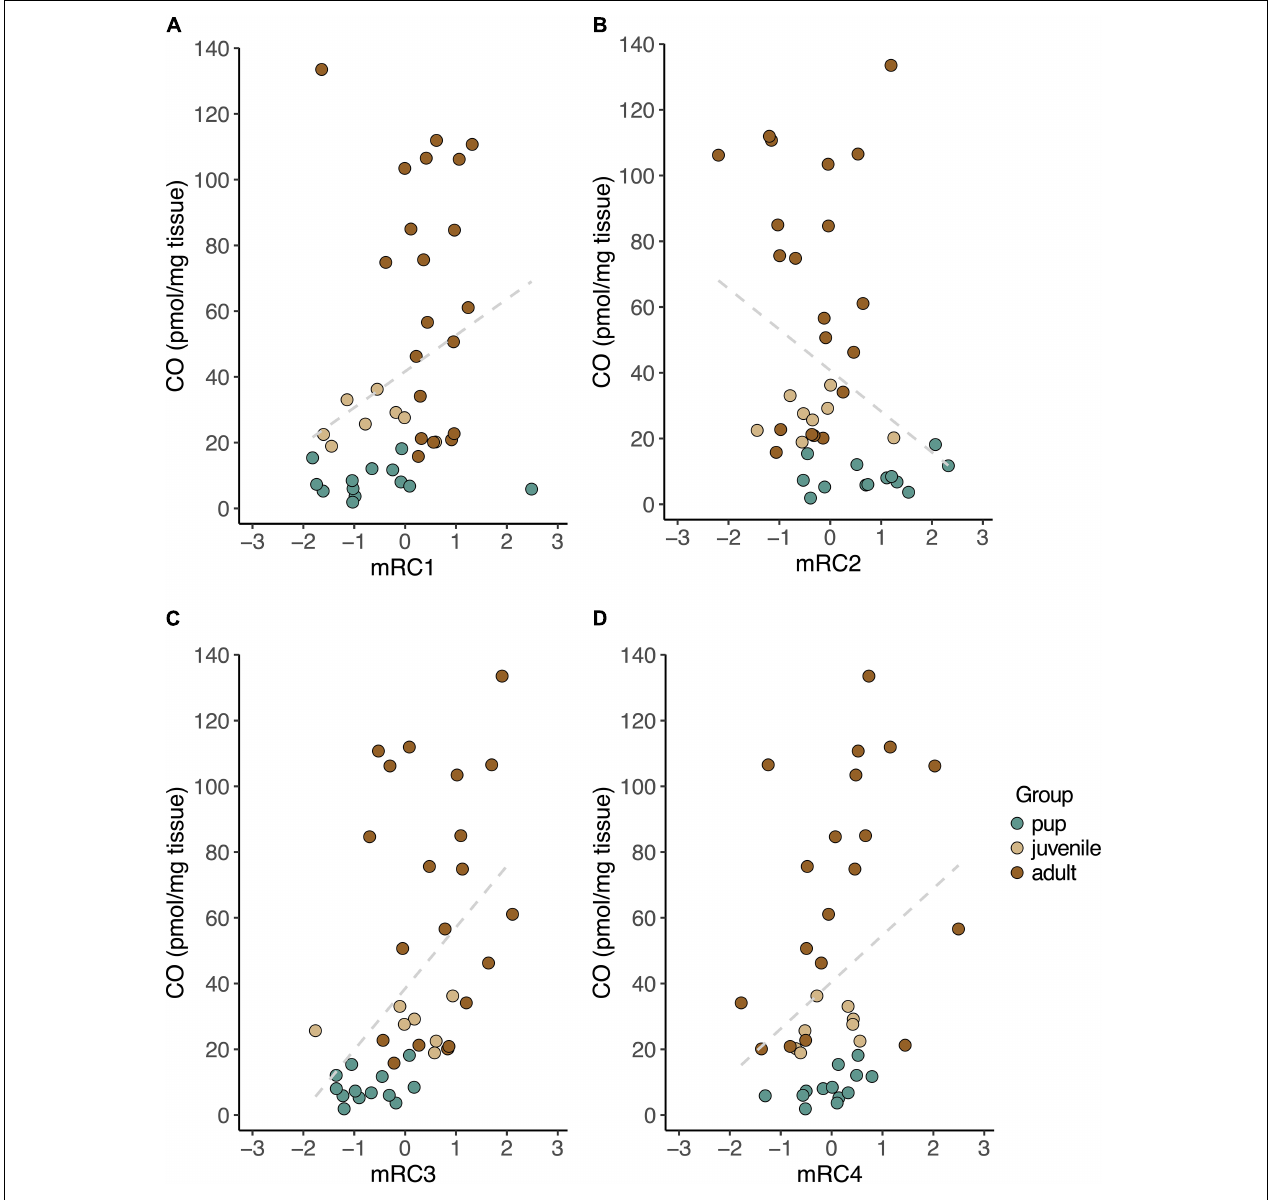
FIGURE 5 | CO levels measured in skeletal muscle were positively correlated with baseline expression of mRC1 ( A ; GPX4 , PRDX6 , PRDX1 , SIRT1 ; r S = 0.43, p = 0.006), mRC3 ( C ; HMOX1 , BVR , GPX3 , PRDX1 ; r S = 0.57, p = 0.0001), and mRC4 ( D ; HMOX2 , NRF2 , IL1B ; r S = 0.33, p = 0.034), and negatively correlated with expression of mRC2 ( B ; PGC1A, ESRRA, ESRRG ; r S = –0.36, p = 0.021) in